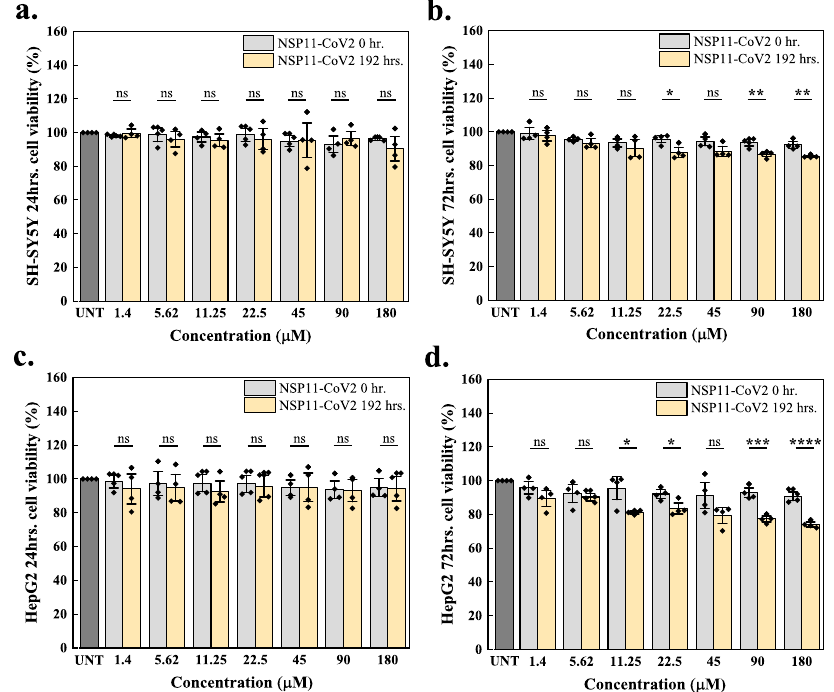
Fig. 10 | Cell viability upon NSP11-CoV2 aggregation using MTT assay. SH-SY5Y and HepG2cellswere treatedwith NSP11-CoV2monomers(grey bars) and amyloid fi brils(192hincubation;lightyellow)for24h( a , c )and72h( b , d ).Thecellstreated with media containing 20mM sodium phosphate buffer (pH 7.4) were used as a control (dark grey bar; UNT is untreated). Diamond symbols on each bar indicate technicalreplicatesandtheerrorbarsrepresenttheSEMofthesereplicates.nsisa non-signi fi cant difference, * p <0.05, ** p <0.01, *** p <0.001, and **** p <0.0001 according to the two-tailed Student ’ s t -test (no adjustments were